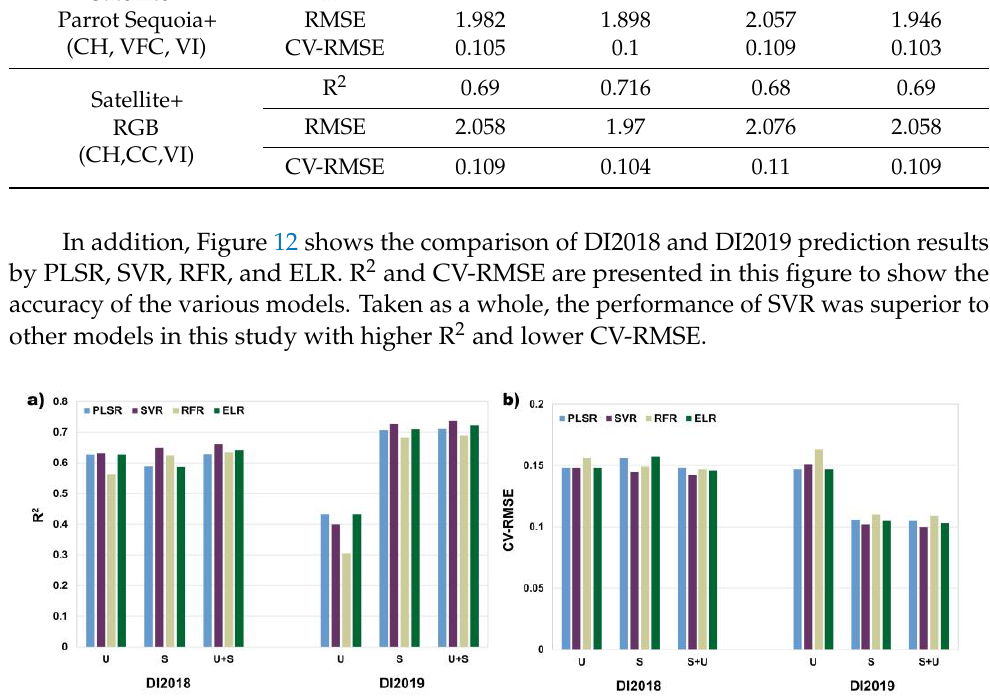
Table 4. Predictions of results from partial least squared regression (PLSR), support vector regression (SVR), random forest regression (RFR), and extreme learning regression (ELR) based on different fea- tures.